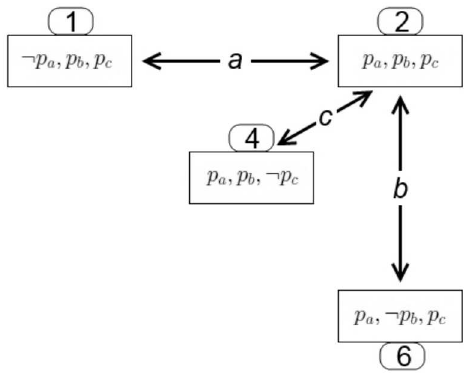
′′ (model after the lack of reaction to Father’s first Figure 3. Model M